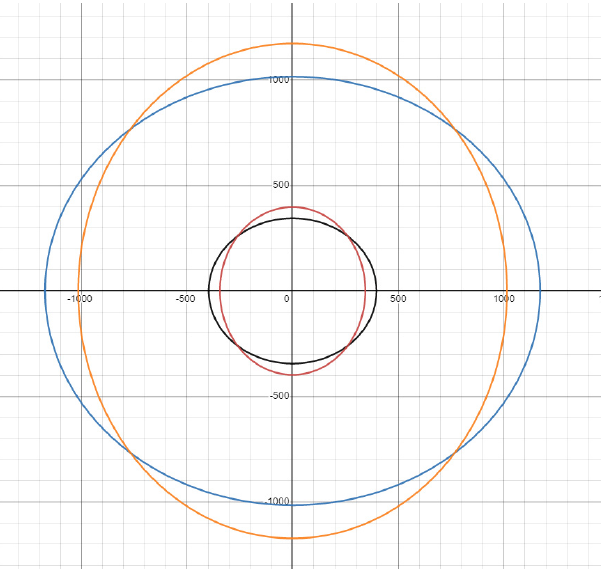
Figure 5. Representation of the four ellipses used to construct the section of the workspace ( 𝑒 (cid:2869) —red, 𝑒 (cid:2870) —orange, 𝑒 (cid:2871) —black, 𝑒 (cid:2872) —blue).